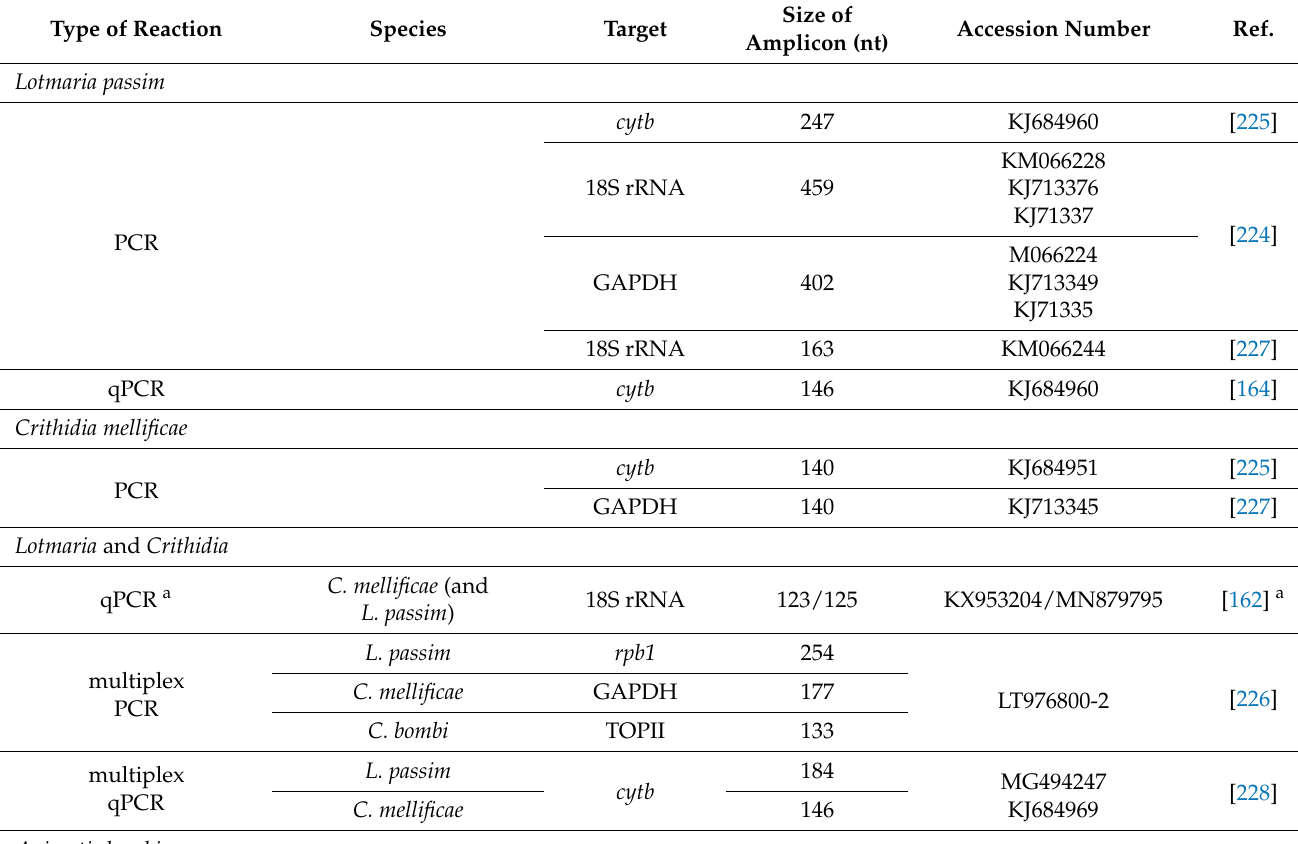
Table 3. Molecular assays for the detection of protozoan pathogens of the